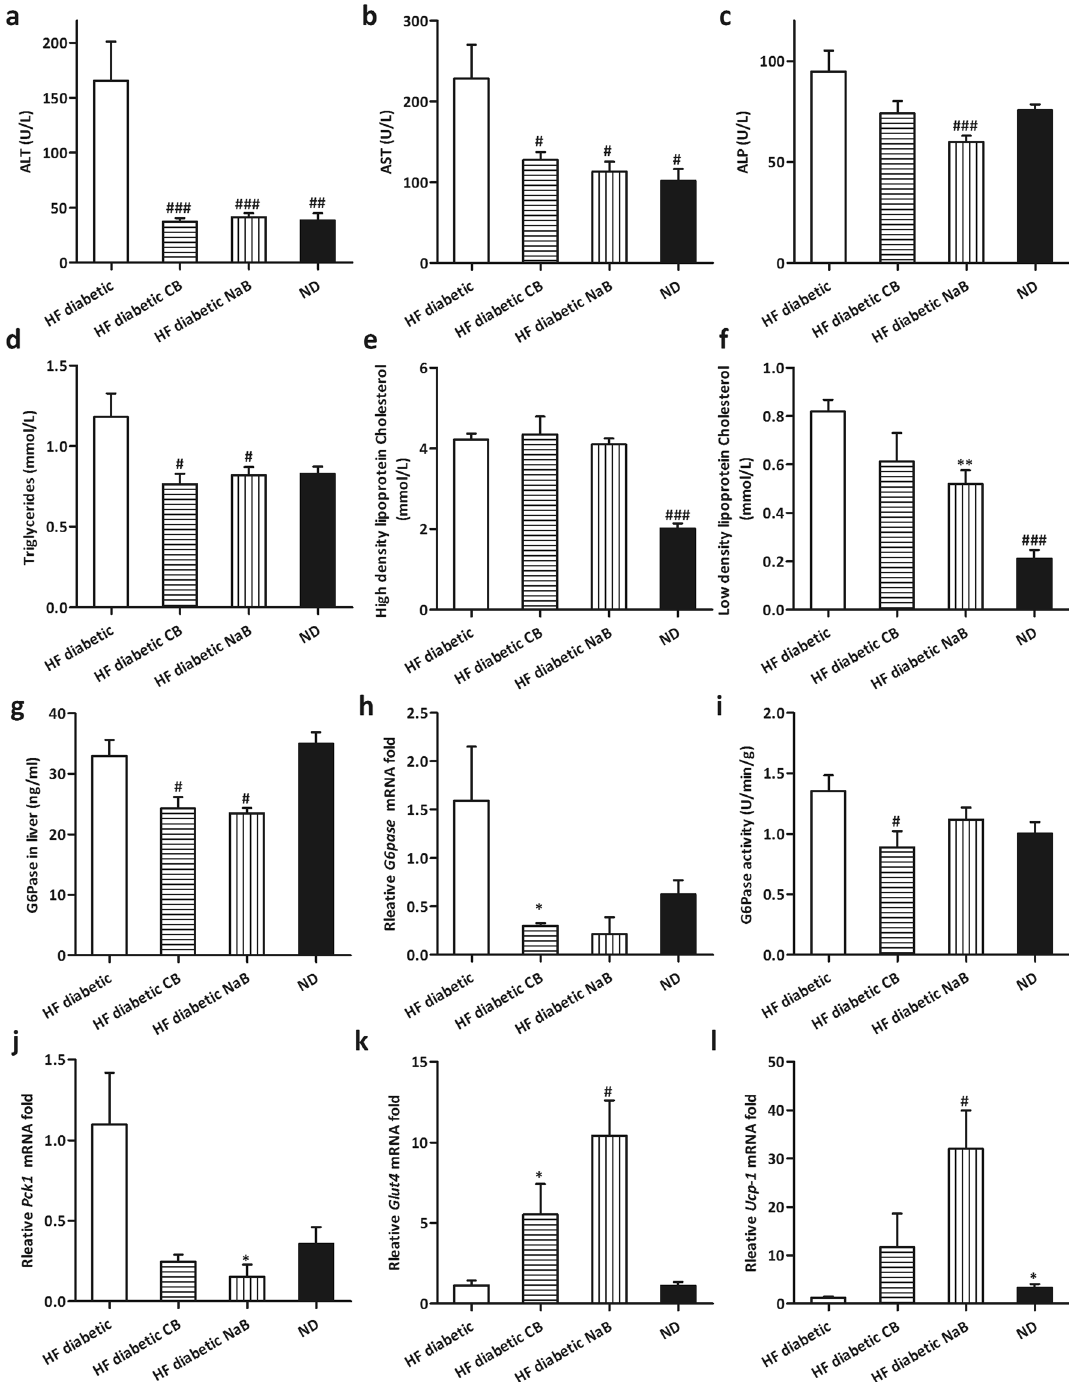
Figure 5. CB0313.1 Lowered Liver Damage and Gluconeogenesis-related Genes in HF Diabetic Mice. Serum ALT ( a ), AST ( b ), ALP ( c ), Triglycerides ( d ), High density lipoprotein Cholesterol ( e ) and Low density lipoprotein Cholesterol ( f ). ( g ) G6Pase protein level in liver determined by ELISA. ( h ) G6pase mRNA in liver. ( i ) G6Pase activity in liver. ( j - l ): The expression of other relevant gluconeogenesis genes was evaluated in the liver of mice fed on the indicated diets. Data are mean ± SEM (n = 3–12 mice per group). #, ##, ### p < 0.05, p < 0.01, p < 0.001 vs HF diabetic control by one-way ANOVA followed by the indicated post hoc test. * , ** , *** p < 0.05, p < 0.01, p < 0.001 vs HF diabetic control by t -test. HF diabetic: high fat diet and streptozotocin, HF diabetic CB: high fat diet and streptozotocin plus CB0313.1, HF diabetic NaB: high fat diet and streptozotocin plus NaB, ND: Normal